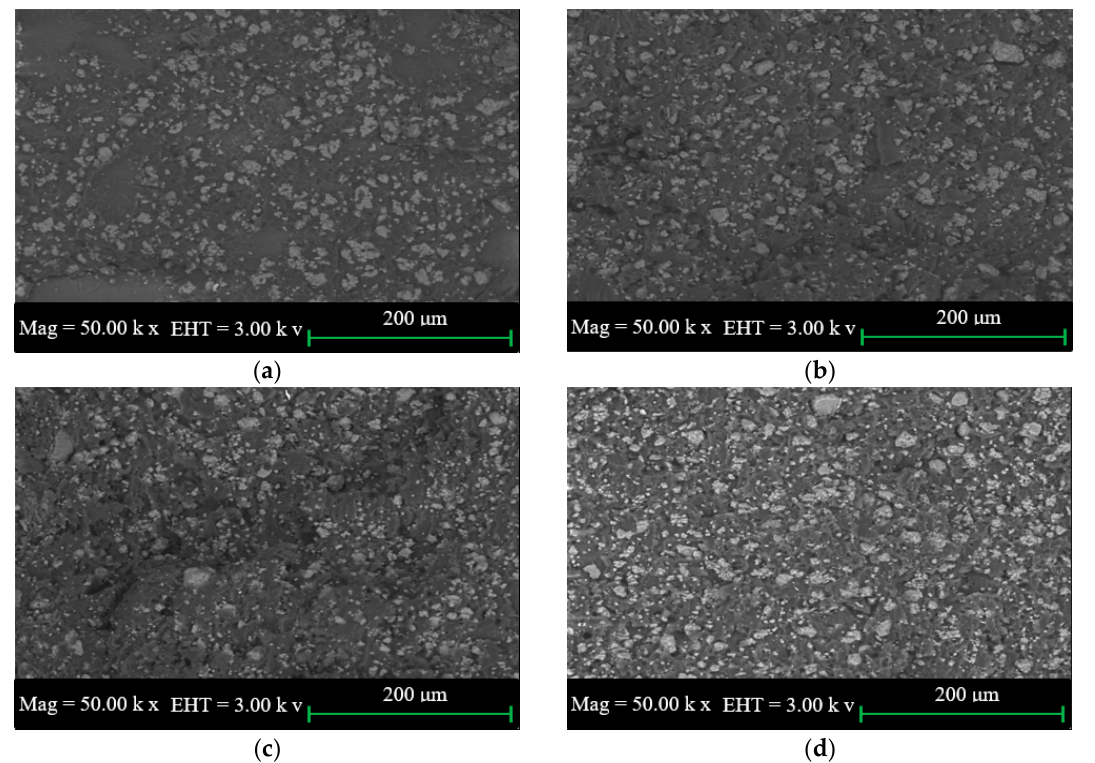
Figure 3. SEM images of impact fracture of PUS for starch wt.% of ( a ) 0.5; ( b ) 1.0; ( c ) 1.5; and ( d ) 2.0.